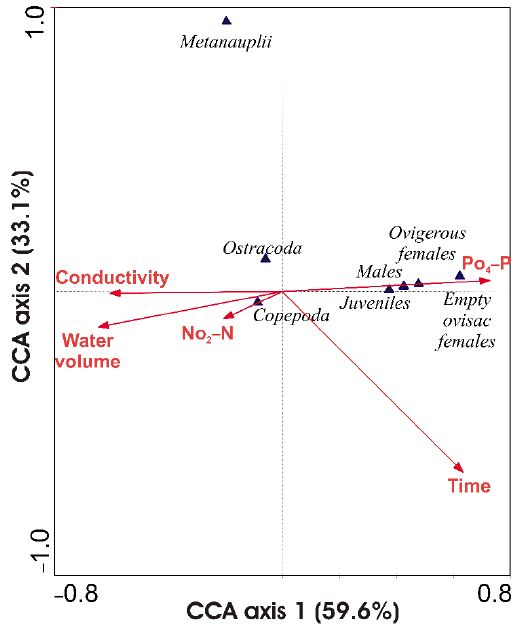
Figure 8. Canonical correspondence analysis results: biplot of biological variables (black triangles) and environmental variables (red arrows). PO 4 -P and NO 2 -N stand for orthophosphates and nitrites, respectively. Axes 1 and 2 explain 59.6% and 33.1% of the total variance, respectively.